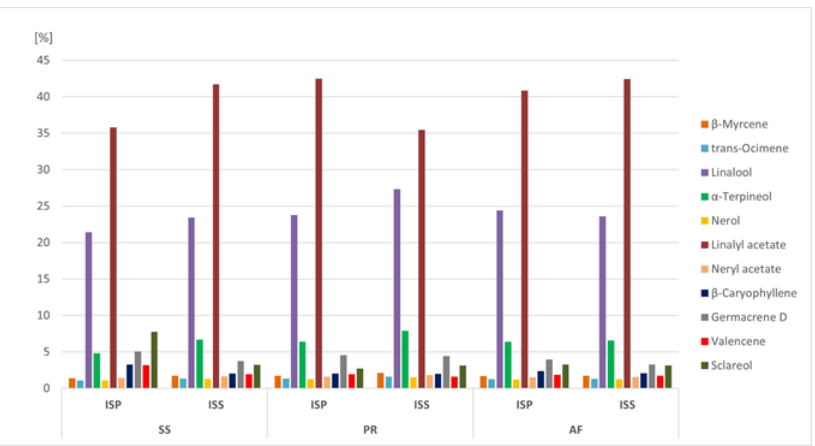
Figure 5. Principal components of the essential oils of the two inflorescence types (TIPS) of the three LPs. Local population code: PR = Prizzi; AF= Alcara Li Fusi; SS = S. Stefano Quisquina. ISP = Primary inflorescences steam; ISS = Secondary inflorescences steam.